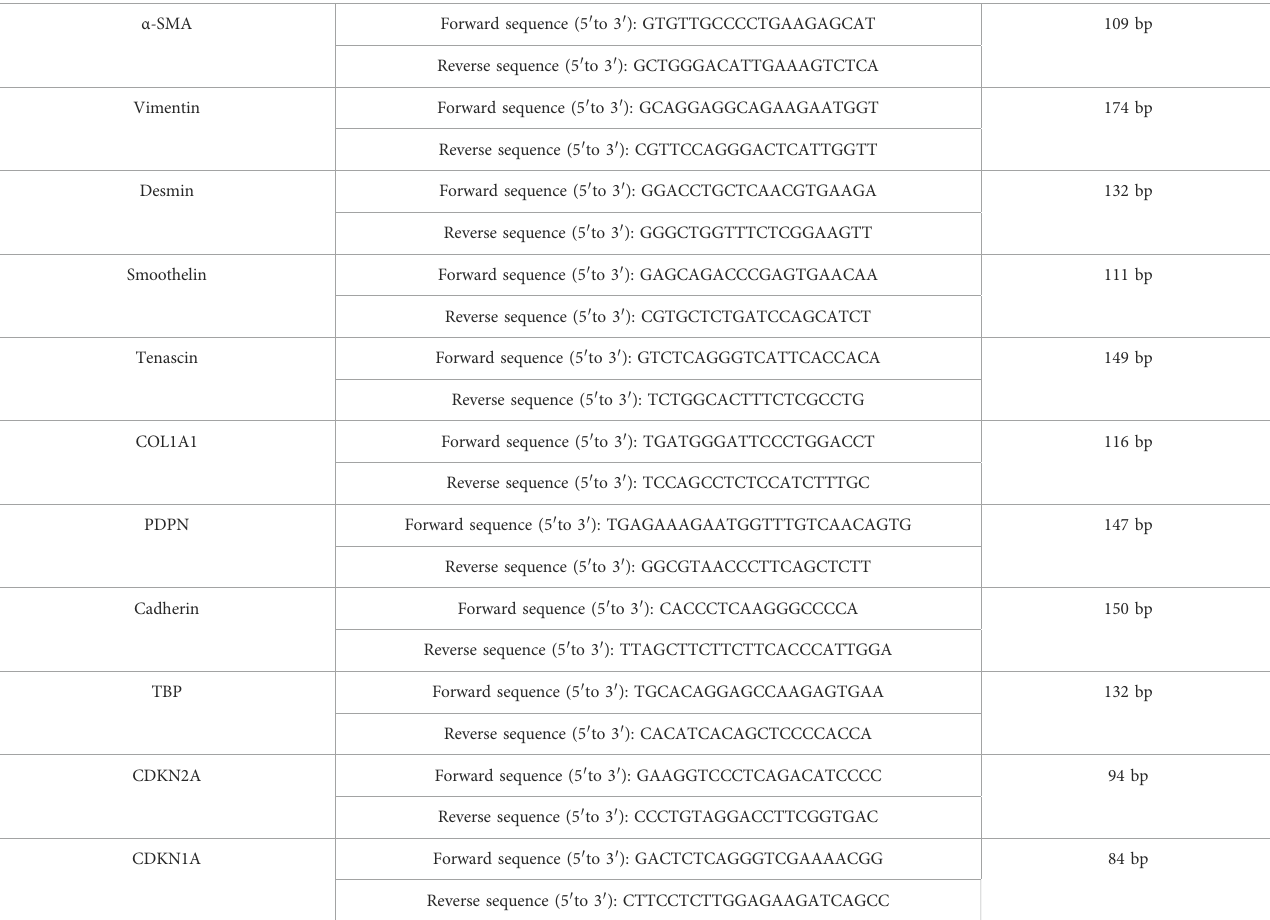
TABLE 1 Real-time quantitative PCR primers and length of products. α